Question: Condense the content of this figure into a single sentence.
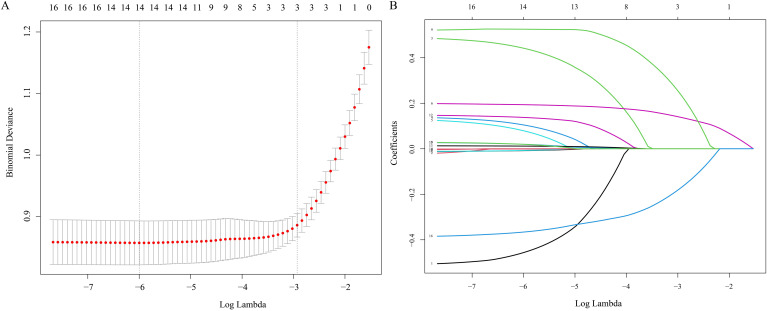
Answer: LASSO regression for candidate variable selection in the atrial fibrillation classification model. (A) Selection of the optimal penalty parameter (λ) by cross-validation; (B) LASSO coefficient profiles of candidate variables.